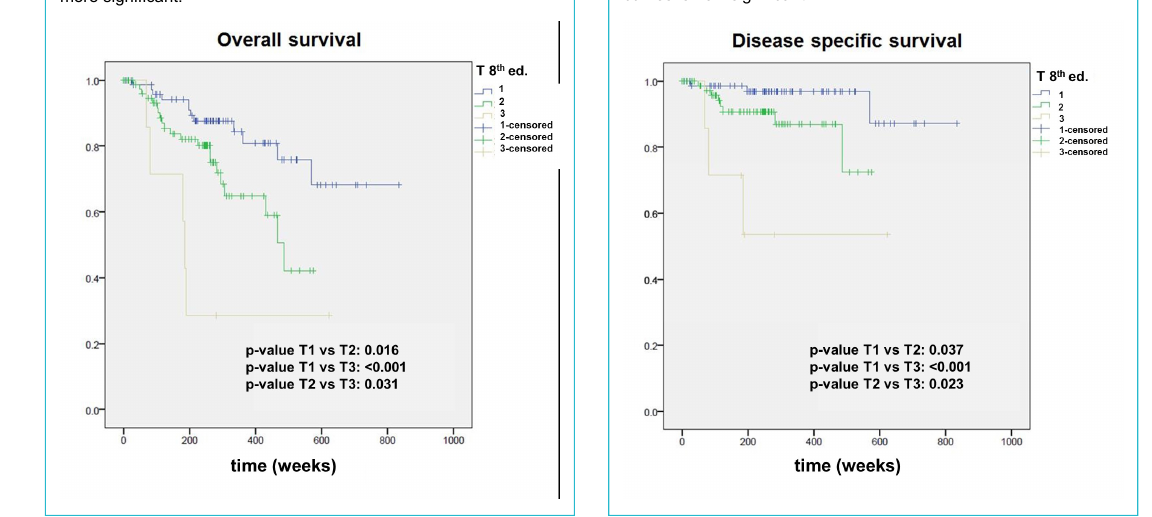
Figure 3: TNM 8th edition. Overall survival: T1 (n = 73), T2 (n = 81) and T3 (new, n = 7); here, all the three curves show a signifi- cant difference. The difference between T1 and T2 becomes even more significant.